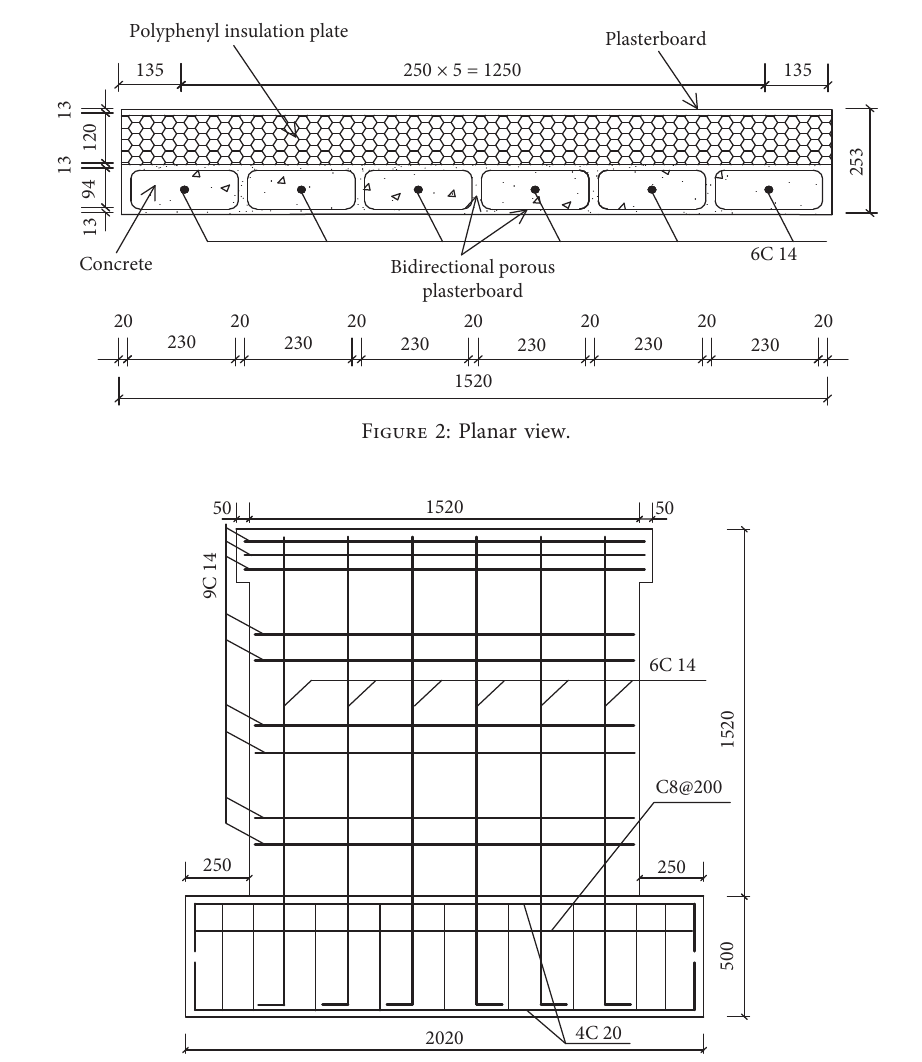
Figure 3: The front reinforcement Table 1: Material mechanical properties.